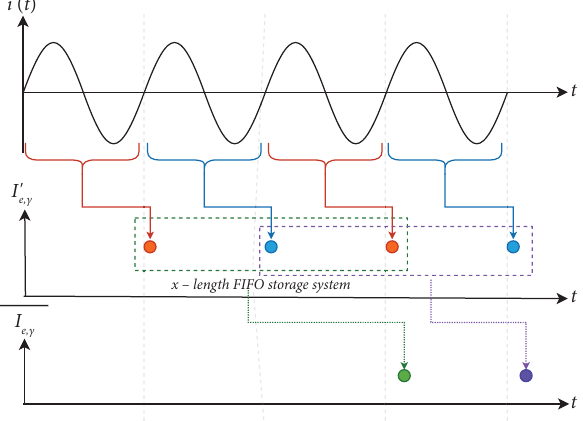
Figure 3: One-cycle sliding and one-cycle width DFT current phasor estimation.